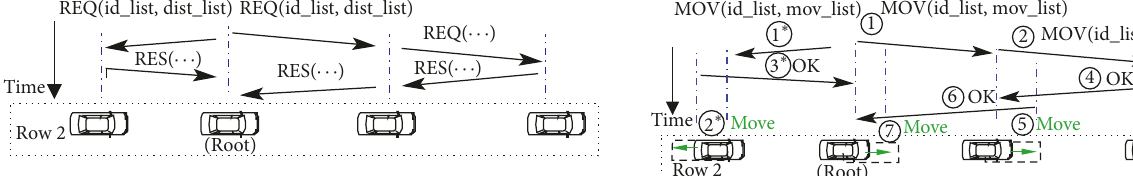
Figure 4: Communication flow for distance vector.